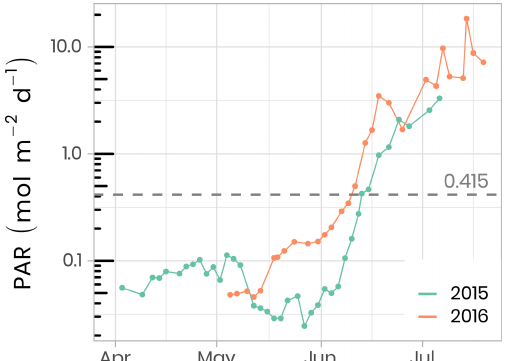
Figure 5. Temporal evolution of daily photosynthetically avail- able radiation (PAR) at the sea-ice–water interface (1.3m depth) for both ice camp missions. The dashed horizontal line shows the 0.415molphotonsm − 2 d − 1 threshold often used in the literature as the minimum light requirement for primary